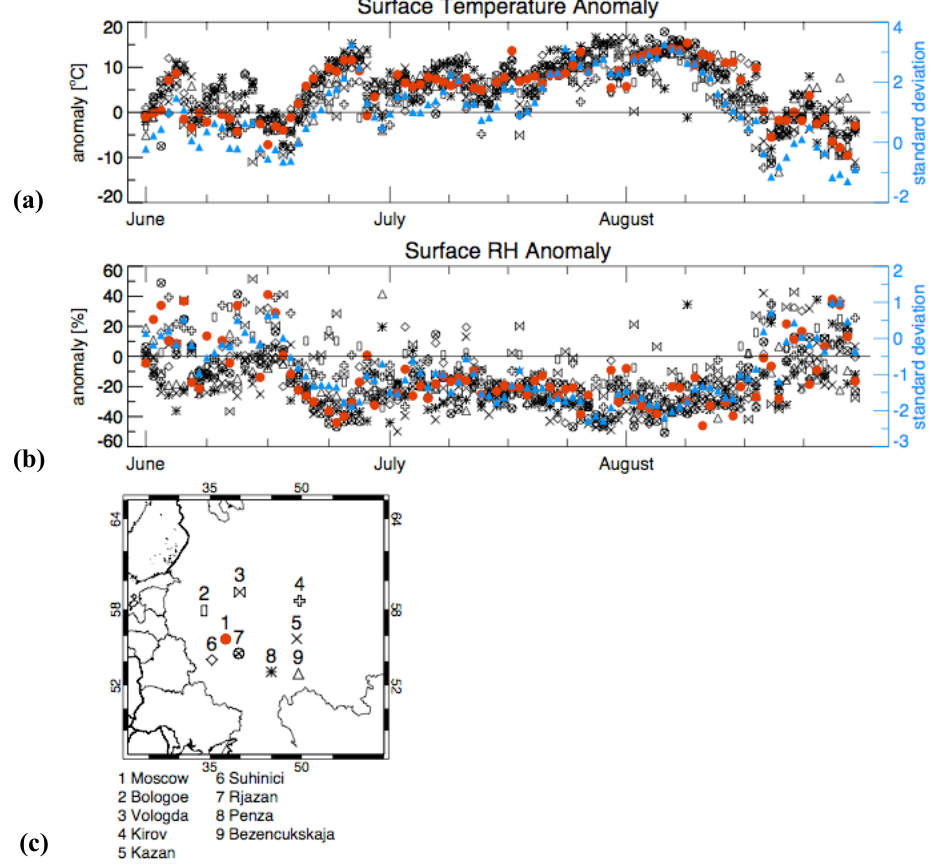
Fig. 1. (a) T sfc and (b) RH sfc anomalies (2010–(1994–2009 mean)) calculated from radiosonde measurements at nine stations in western Figure 1. (a) T and (b) RH anomalies (2010 – (1994-2009 mean)) calculated from 673 Russia. Radiosonde locations, including symbol legend for (a) and (b) are mapped in (c) . The red dots highlight data from the Moscow sfc sfc site. Blue triangles show the daily standard deviation of the anomalies using the mean of all station anomalies. The zero line pertains to the radiosonde measurements at nine stations in western Russia. Radiosonde locations, 674 anomaly including symbol legend for (a) and (b) are mapped in (c). The red dots highlight data 675 from the Moscow site. Blue triangles show the daily standard deviation of the anomalies 676 using the mean of all station anomalies. The zero line pertains to the anomaly y-axis. 677